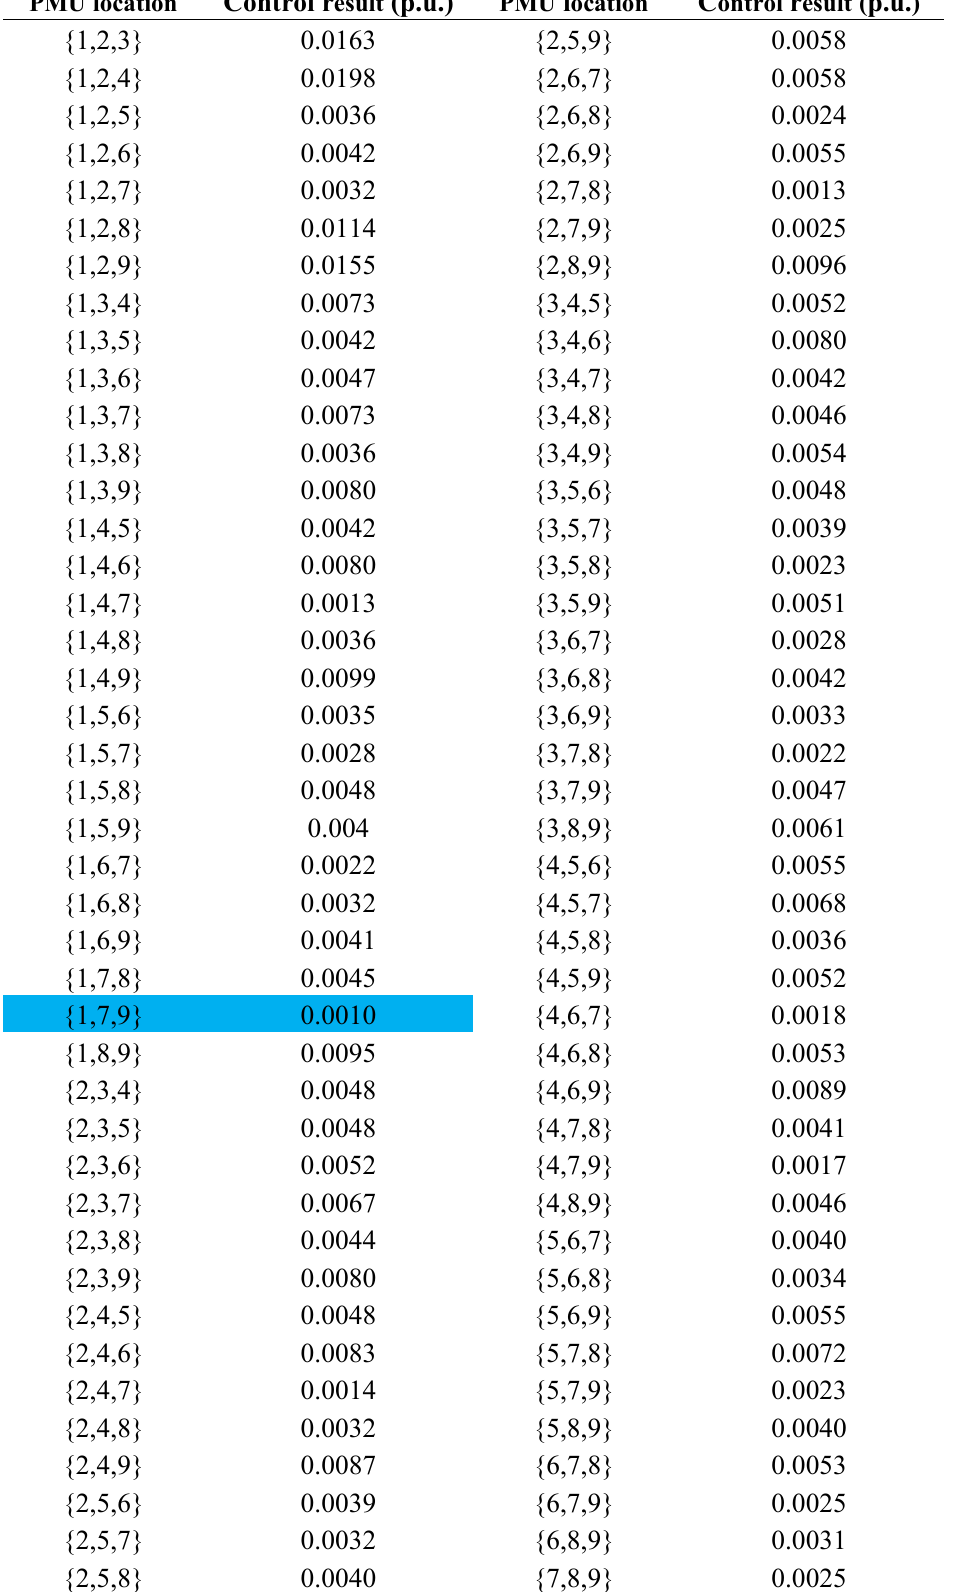
Table 1. Control effect of all the